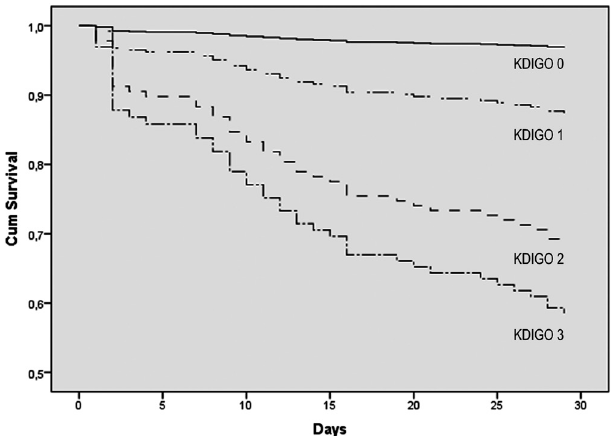
Fig. 2 - Overall survival curves of patients who underwent cardiac surgery, according to the KDIGO